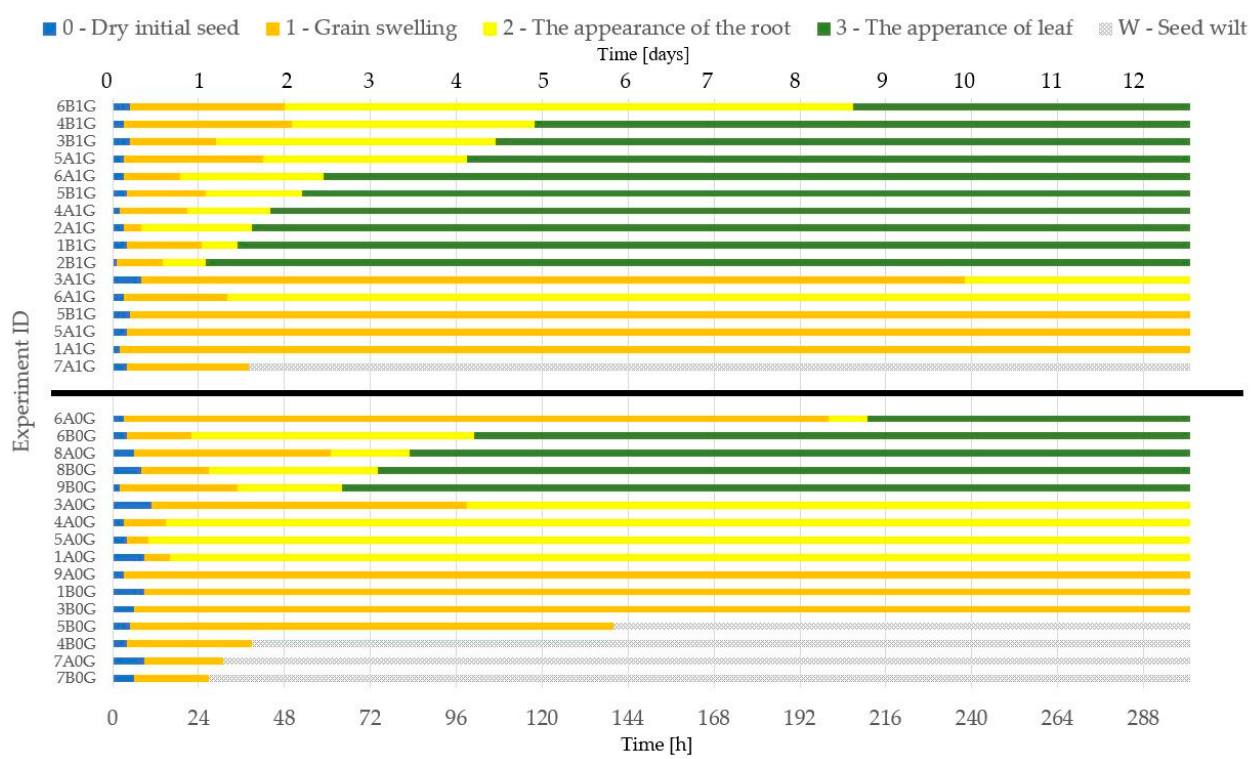
Figure 6. Comparison of seed growth stages in time from the experiments, conducted in 1 g gravity (upper part) and microgravity (lower part) stimulations.